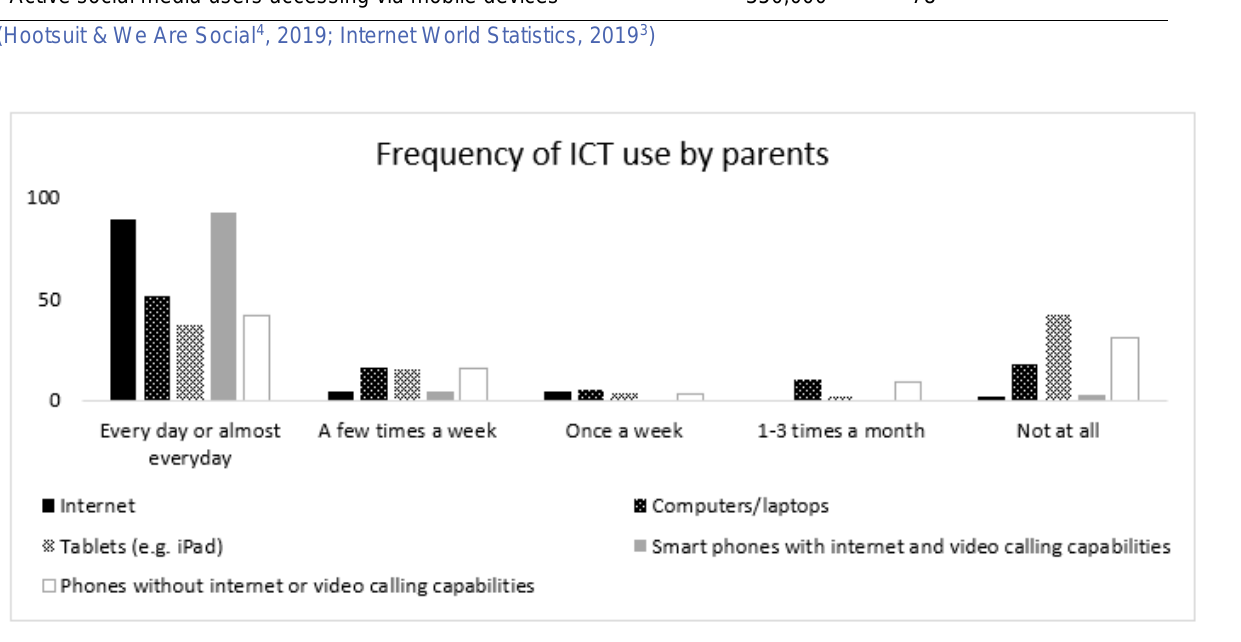
Figure 4. Frequency of ICT use by parents in their daily